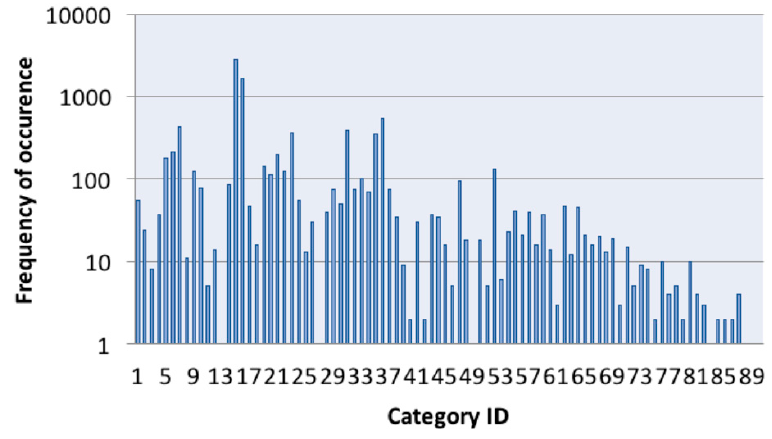
Figure 3. Reuters dataset: category frequency distribution.